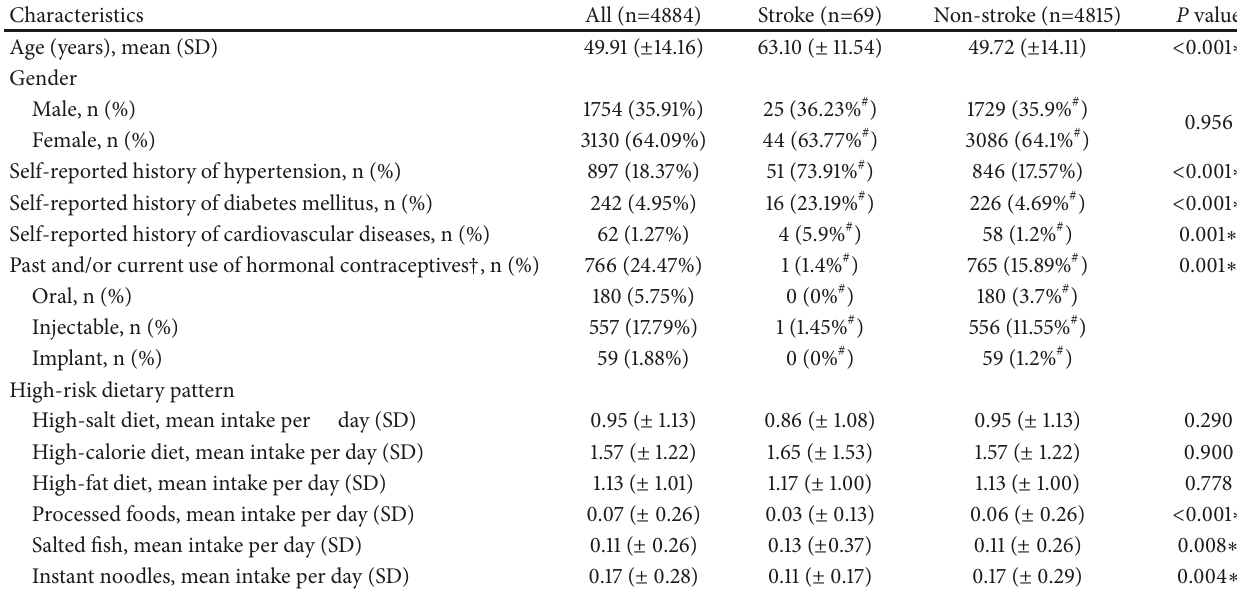
Table 1: Descriptive statistics of study samples stratified by